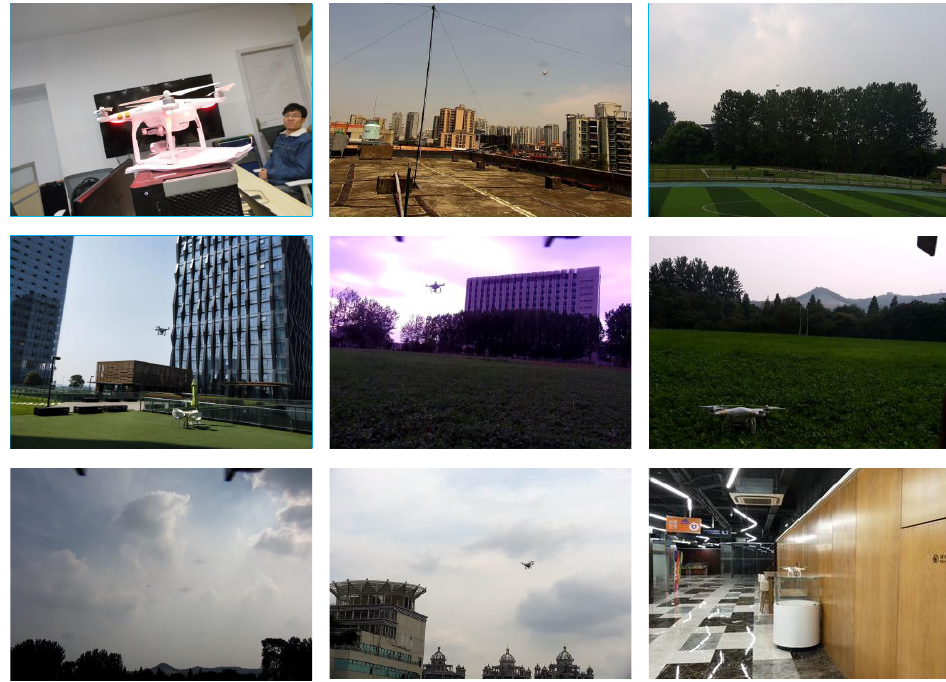
Figure 8. Collected dataset to train and evaluate a network. Random scale, flip, crop, enhancement, and rotation operations were utilized for data augmentation during training. Each model was trained using the Adam optimizer. The initial learning rate was set to 0.001 and linearly annealed down (using the cosine decay rule) when the training epoch did not decrease for two consecutive epochs. The backbone of the CFACN detection network used ResNet-18. The loss functions used were focal loss [24] (with α = 2 and β = 4) for key point estimation and L1 loss for both size and local offset estimation. During training, each network model trained for 100 epochs with a total batch size of